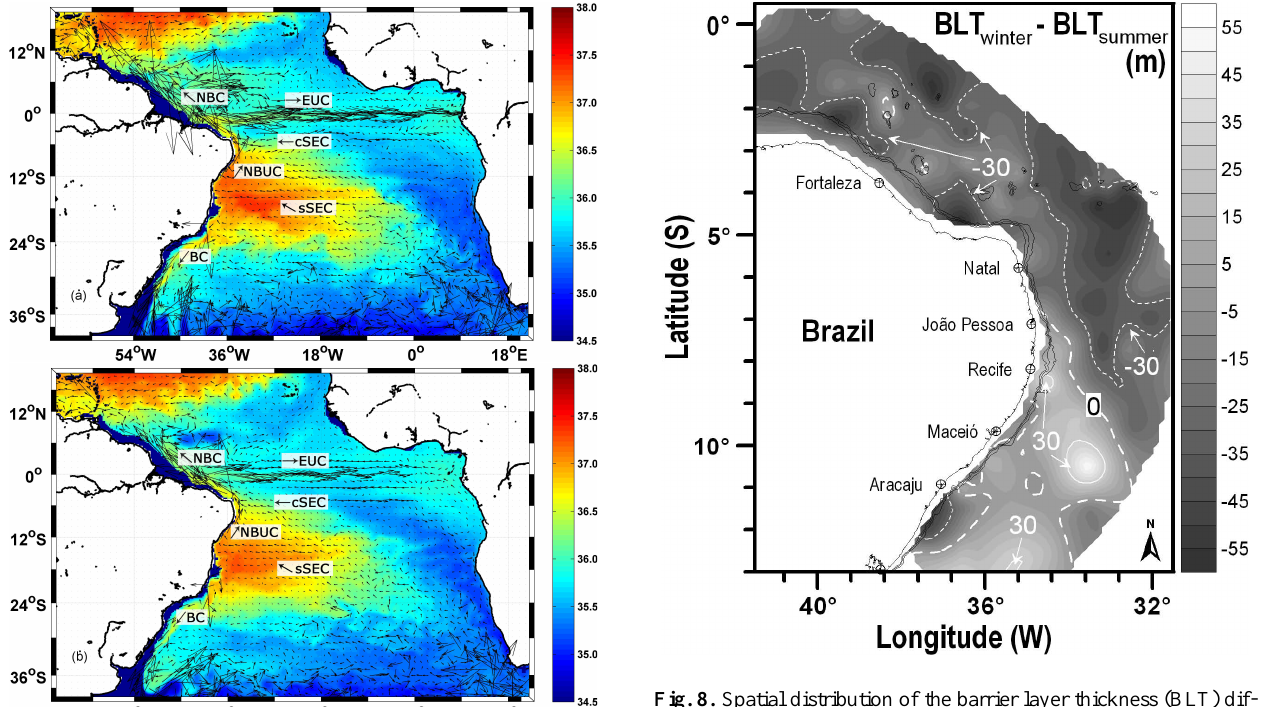
Fig. 8. Spatial distribution of the barrier layer thickness (BLT) dif- ference between late austral winter (August–October 1995) and aus- tral summer (January–April 1997). Thin solid (dashed) lines repre- sent positive (negative) values. Large dashed lines represent null